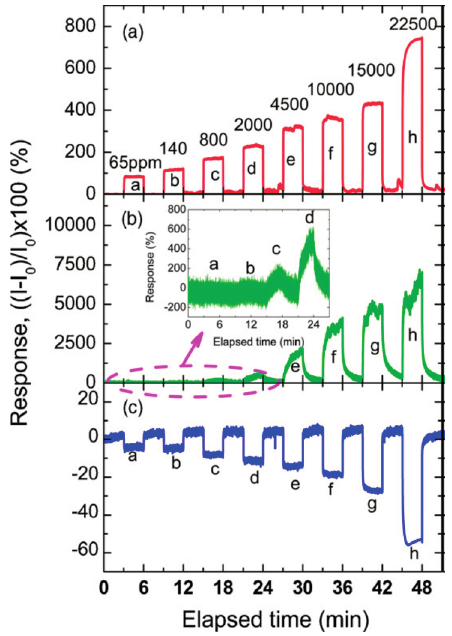
Figure 9. Comparison of the response signals measured by three different detection methods. This graph shows the response signals on the color-difference ( a ), current ( b ), and PL intensity ( c ). Reprinted with permission from Reference [80]. Copyright 2010 Elsevier